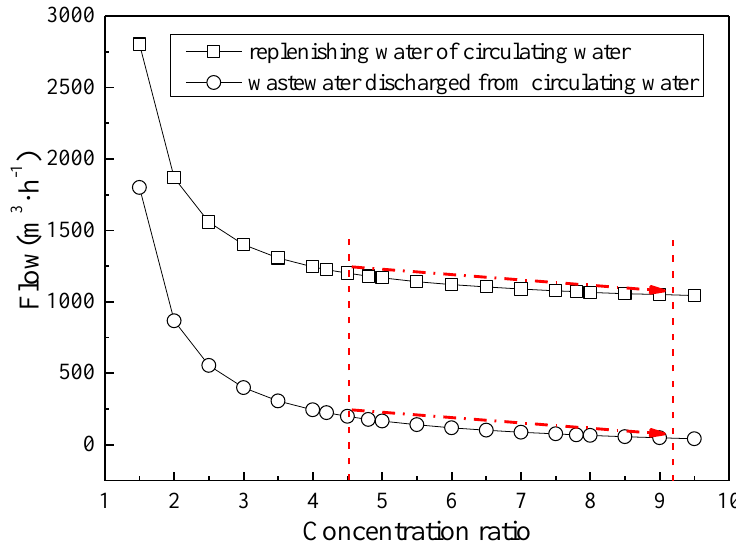
Figure 7. Amount of water replenished to and amount of wastewater discharged from the circulating water system for different concentration ratios.